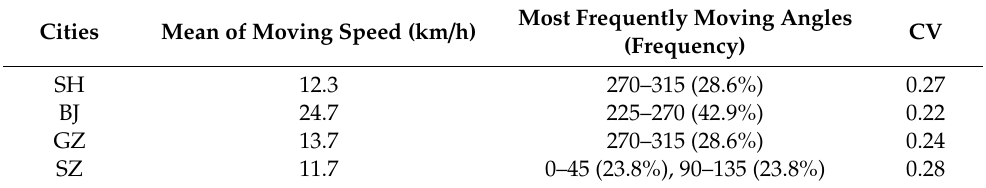
Table 5. A dynamic analysis of the Rx3h centroids at a 3-h time scale (temporal resolution = 30 min). “Frequency” represents the percentage of the events during